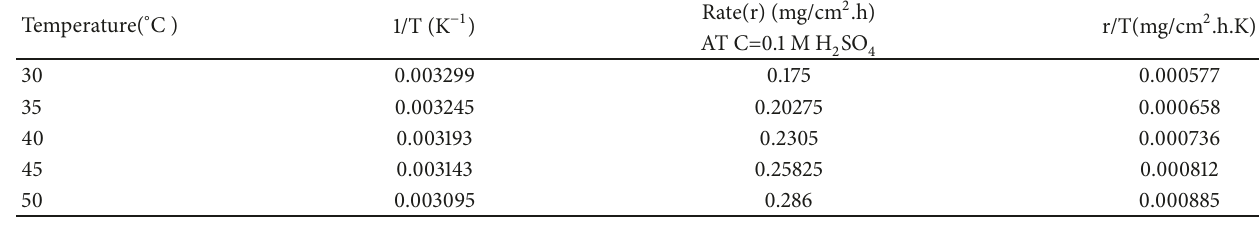
Table 2: Rate of reaction (mg/cm 2 .h) of mild steel in sulfuric acid at 0.1 M concentration and at different temperature (30-50 ∘ C). Temperature( ∘ C )